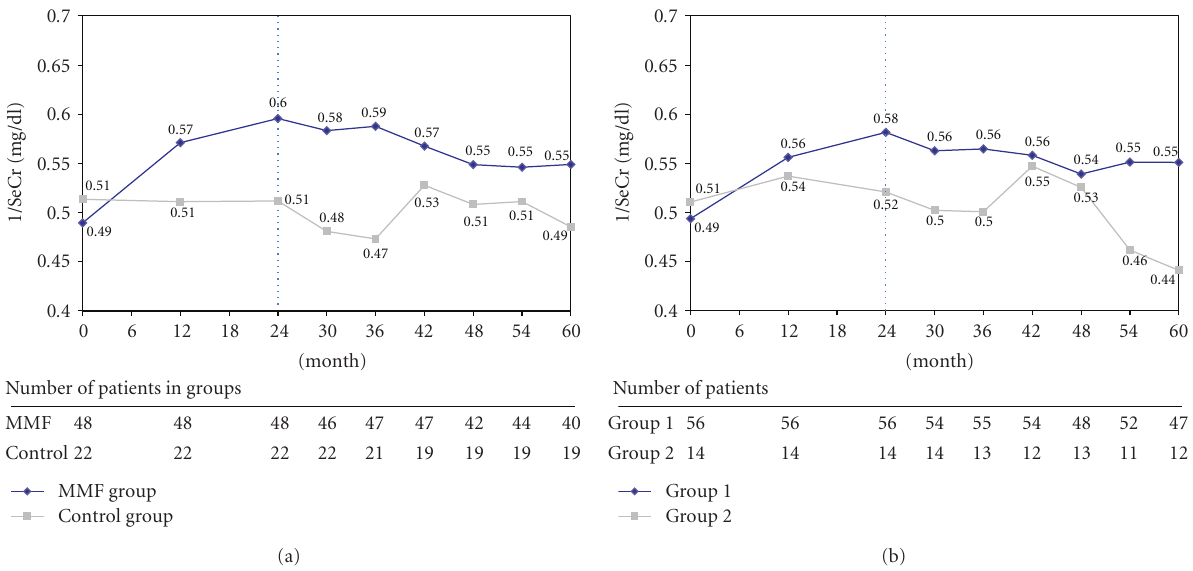
Figure 3: (a) Evolution of inverse of creatinine (1/SeCr) over time in the randomization population (MMF group versus control group). (b) Evolution of inverse of creatinine (1/SeCr) over time in the on-treatment population (group I versus group II). The vertical, dotted line separates initial study phase and follow up phase.